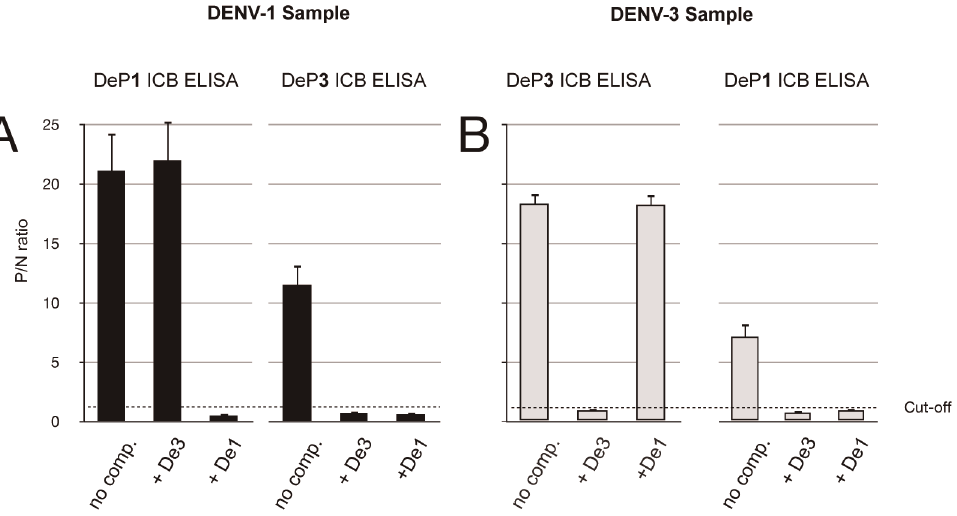
Figure 3. Competitive ICB ELISA using two cross-reacting samples. A . Reactivity (P/N ratio) of a DENV-1 sample. Black columns from left to right: without addition of competitive antigen (no comp.) a strong reaction with DeP1 (P/N ratio 21.1) is seen. Next column: Upon competition with De3 (De3 + ) the reaction with DeP1 (P/N ratio 22) remains almost unchanged. Next column: autologous competition with De1 ( + De1) results in a P/N ratio of , 1. Cross-reactivity with DeP3 antigen (next three columns): without competition (no comp.) the P/N ratio is 11.5. With competition using De3 ( + De3) and De1 ( + De1) all reactivity disappears. B . The same experiment is carried out for the DENV-3 sample (grey columns). Without competition (no comp.) a strong reaction with DeP3 antigen is seen (P/N ratio 18.5). Addition of De1 ( + De1) does not change the positive reaction (P/ N ratio from 18.3 to 18.2). The strong cross-reactivity with DeP1 (P/N ratio 7.1) without competition (no comp.) disappears both upon addition of De3 ( + De3) and of De1 ( + De1).